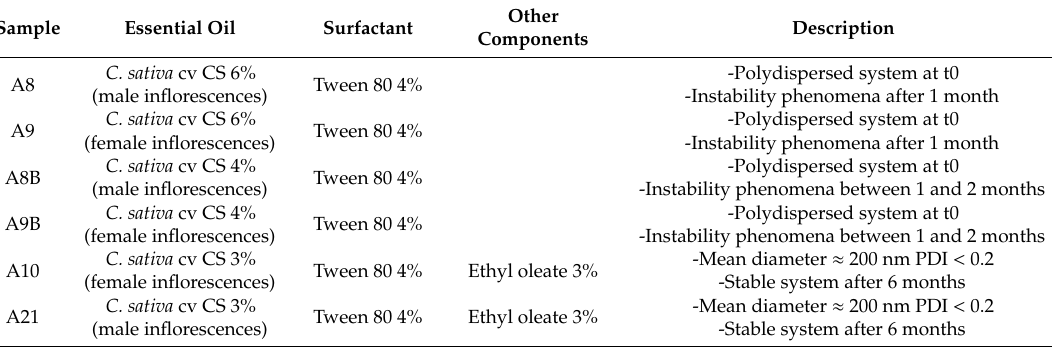
Table 3. Composition and physicochemical properties of hemp EO-based nanoemulsions.